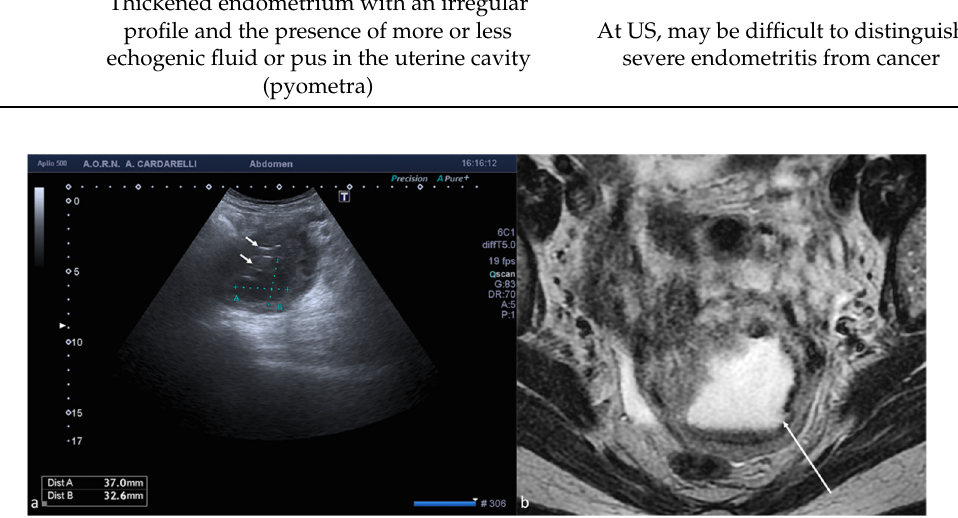
Figure 7. Pyometra. TSA-US scan of the uterus ( a ) shows a distended uterine cavity containing complex fluid with echogenic foci (short arrows). Axial T2w MRI imaging (b) confirms the diag- nosis showing pus collection into uterine